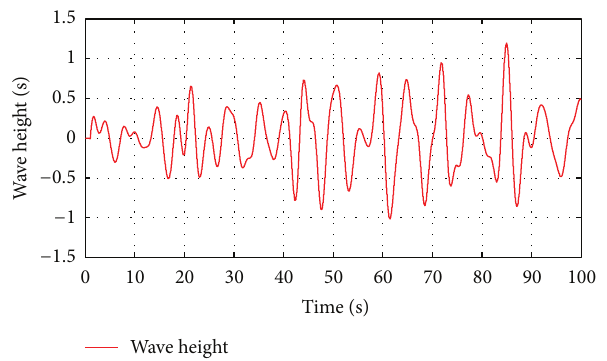
Figure 11: Wave height.